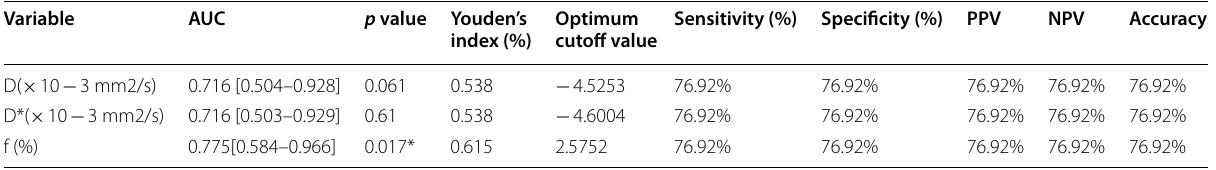
Table 4 Predictive performance for identifying tumor response to